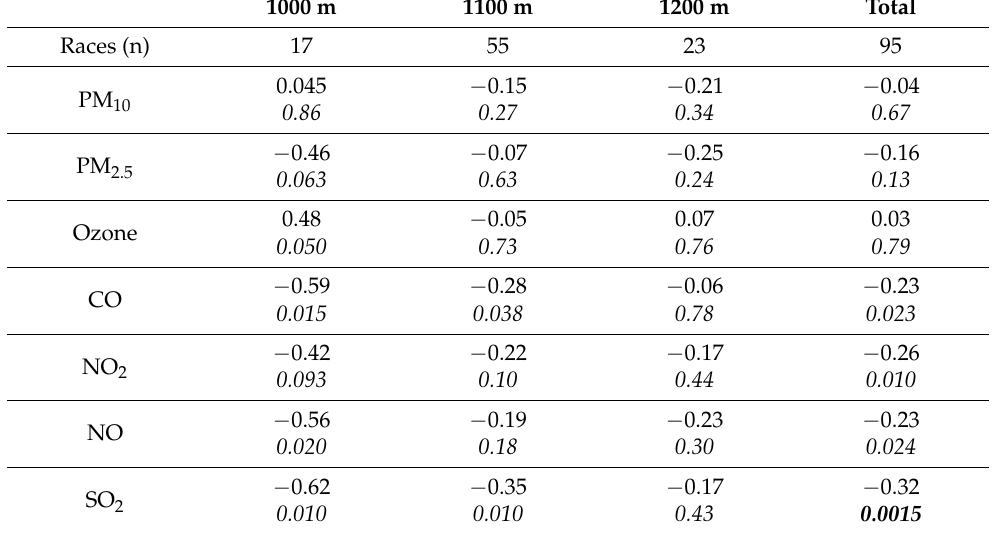
Table 3. Spearman’s Rho (above) and p -values (in italics below) calculated between the winning horse’s speed and the mean values of the pollutant concentration during the six hours prior to the race in the “Conditional” category for the distances of 1000, 1100, 1200 m and for all the races together. The n for O 3 were 17, 51, 19 respectively, while for the total races it was 87. Significant p -values, using the Bonferroni adjustment. are shown in bold italics. 1000 m 1100 m 1200